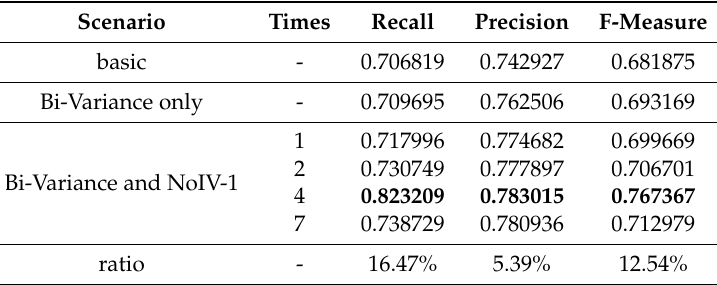
Table 4. Results of SuBSENSEexecuted on three